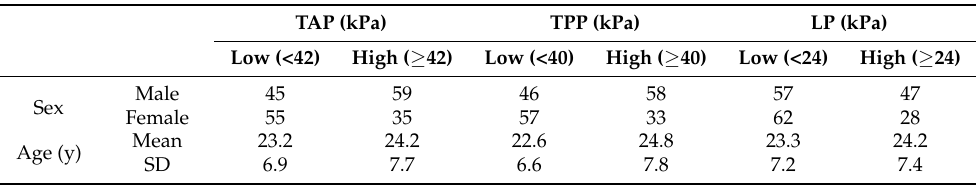
Table 1. Sex and age distribution of patients with each group.